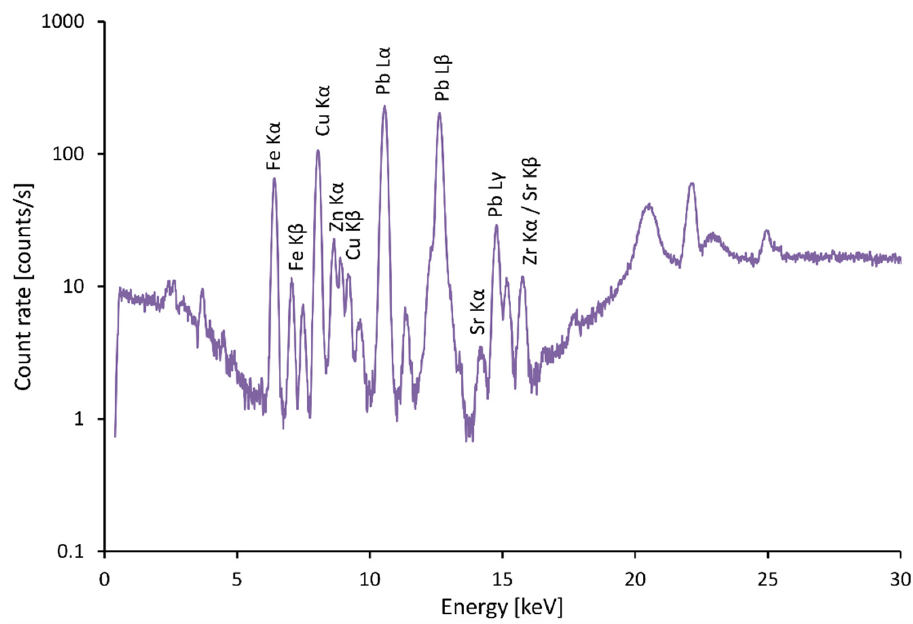
6 of 10 Figure 5. Spectrum of cinnabar, Coat of arms in right bust of Charles IV.